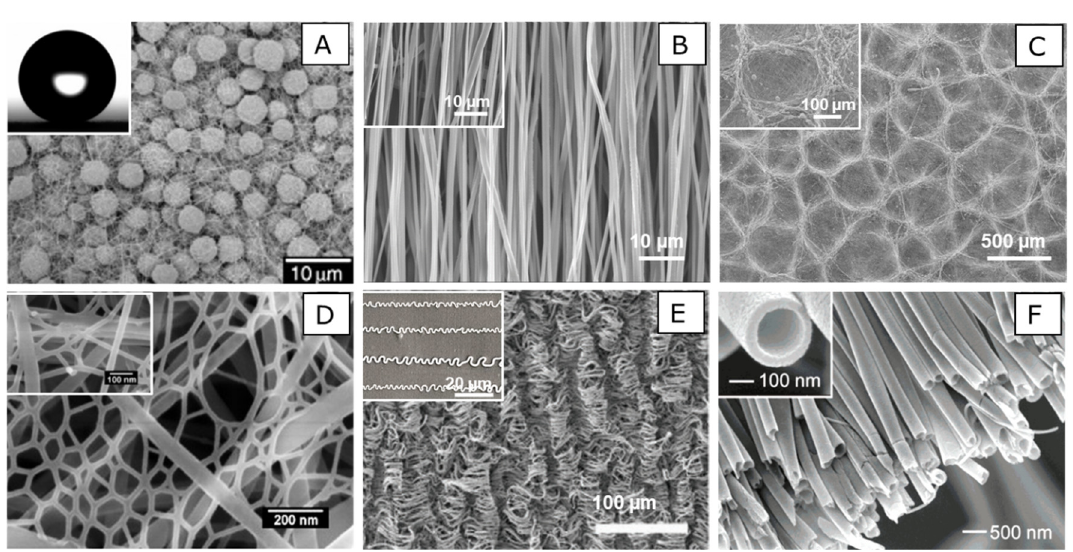
Figure 5. Different nanofibrous structures fabricated by electrospinning approach. SEM images of ( A ) a porous microsphere/nanofiber composite, ( B ) an aligned nanofiber, ( C ) a honeycomb nanofiber, ( D ) a spider ‐ web ‐ like nanofiber, ( E ) a curly nanofiber, and ( F ) a nanotube. Porous microsphere/nanofiber